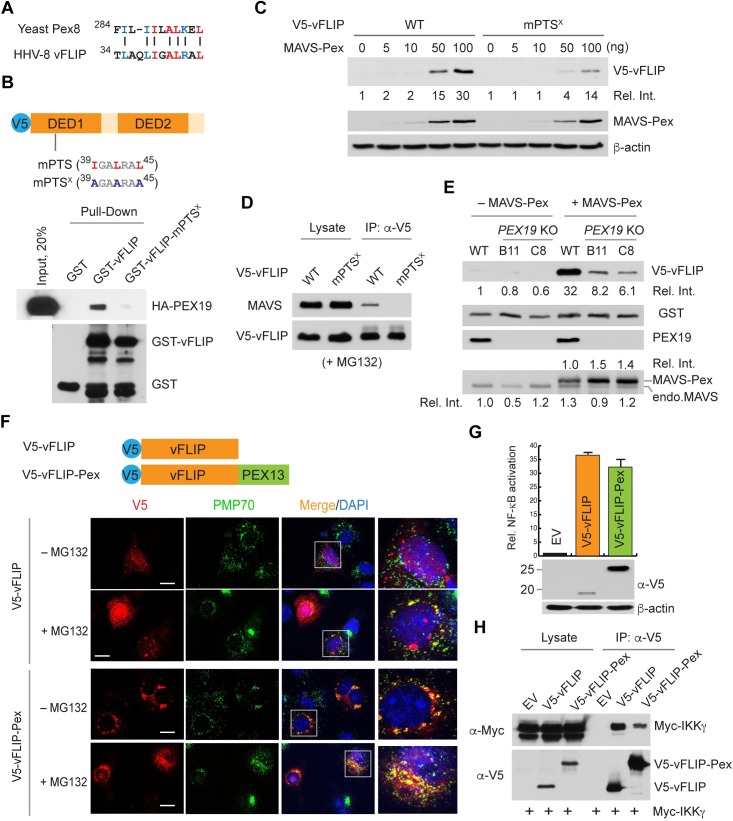
Functional vFLIP is targeted to peroxisomes in a PEX19-dependent manner.(A) Alignment of putative mPTSs of yeast Pex8 and vFLIP (residues 34–45). Identical and similar residues are highlighted in red and blue, respectively. (B) In vitro GST pull-down assay using purified GST, GST-vFLIP, and GST-vFLIP mPTSX proteins and the extracts from 293T cells expressing HA-PEX19. (C) Immunoblots of extracts from MAVS KO 293T cells transfected with V5-vFLIP WT and mPTSX along with the indicated amounts of MAVS-Pex vectors. Relative V5-vFLIP band intensities normalized by β-actin are shown below the blot. (D) Co-IP assay using extracts from 293T cells transfected with V5-vFLIP WT and mPTSX and treated with 10 μM MG132 for 8 h. (E) Immunoblots of extracts from WT and PEX19 KO 293A cell lines transfected with vectors expressing V5-vFLIP and GST with or without MAVS-Pex vectors. Relative V5-vFLIP band intensities normalized by GST are shown below the blot. “Endo.MAVS” indicates endogenous MAVS. Relative MAVS-Pex and endogenous MAVS band intensities are shown above and below the MAVS immunoblot panel, respectively. (F) Immunostaining of 293A cells transfected with V5-vFLIP and V5-vFLIP-Pex. DMSO or MG132 was added at 8 h to the cell culture before fixation. The insets show enlarged portions of the images, revealing co-localization or juxtaposition of V5-vFLIP with peroxisomal marker PMP70. (G) NF-κB reporter assay in 293T cells transfected with empty vector, V5-vFLIP, and V5-vFLIP-Pex vectors together with an NF-κB-luciferase reporter plasmid. The corresponding cell extracts were then analyzed by immunoblotting with anti-V5 and β-actin antibodies. Data are presented as mean ± SD of triplicate samples. (H) Co-IP assay using extracts from 293T cells transfected with Myc-IKKγ expression plasmid and empty vector, V5-vFLIP, or V5-vFLIP-Pex vectors.